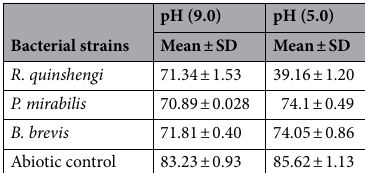
Bacterial strains